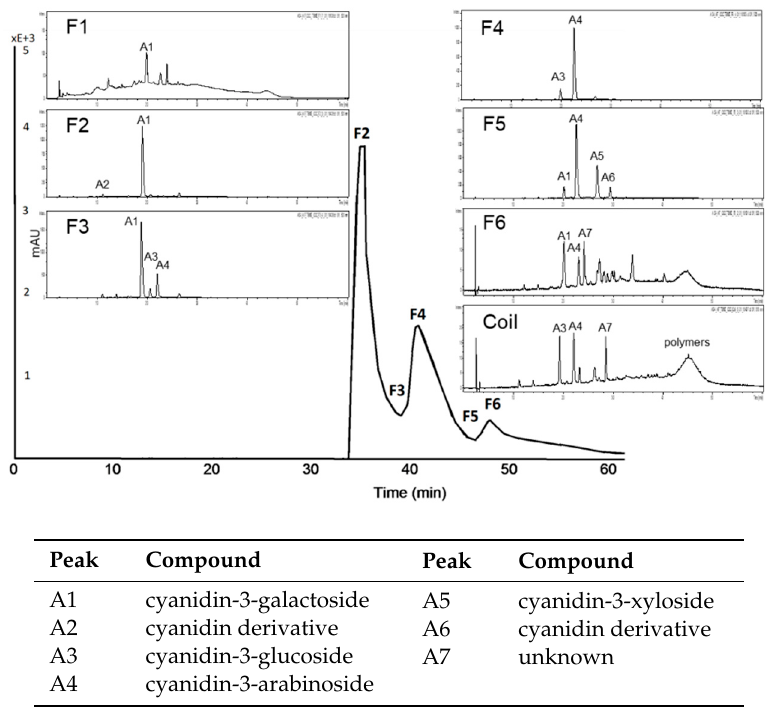
Figure 7. HPCCC chromatogram at a wavelength of λ 520 nm of A-AF and HPLC-ESI-MS/MS chromatograms of the composition of each fraction.